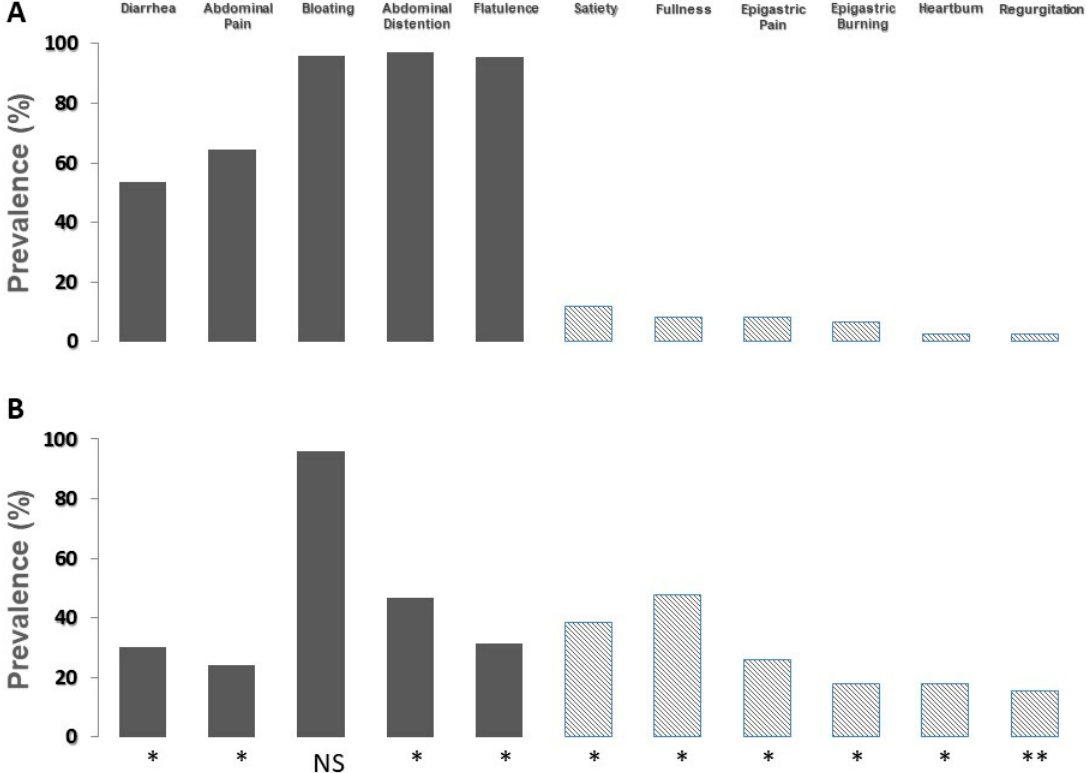
Figure 3. Prevalence of moderate-to-severe symptoms attributed to the ingestion of lactose by the group of 268 patients, according to lactose breath test results. ( A ) Patients with positive lactose breath test. ( B ) Patients with negative lactose breath test. * = p < 0.0001 and ** = p < 0.007 for the comparison of the severity of each symptom between patients with positive and negative lactose breath test. Grey bars indicate intolerance-related symptoms; bars with diagonal lines indicate dyspeptic- and reflux-related symptom.